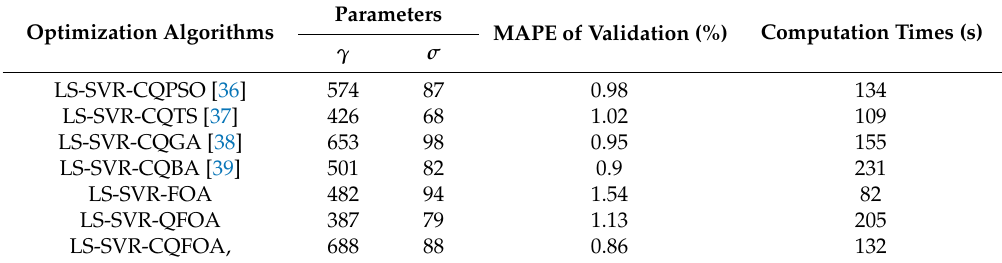
Table 5. Parameters combination of LS-SVR determined by CQFOA and other algorithms for GEFCom2014 (Jan.).